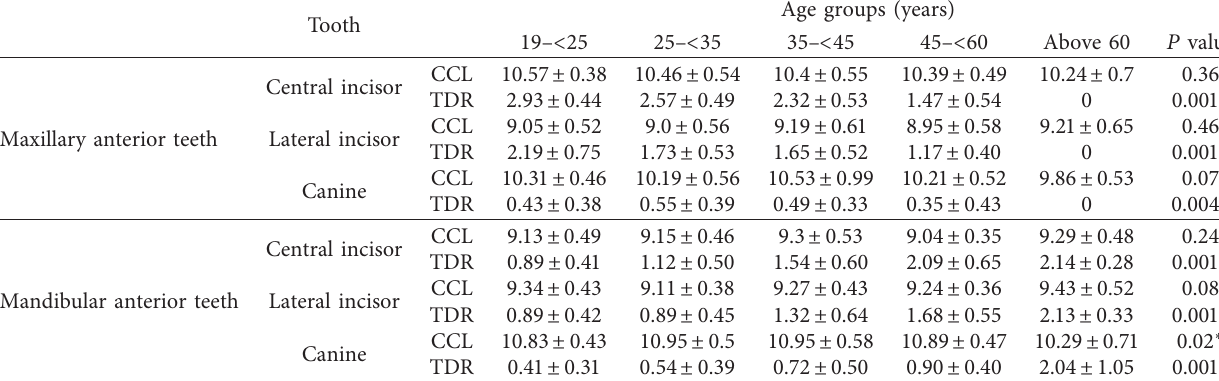
Table 3: Mean ± standard deviation (mm) of clinical crown length (CCL) and vertical tooth display at rest (TDR) distributed on the five age groups and difference between them using ANOVA.